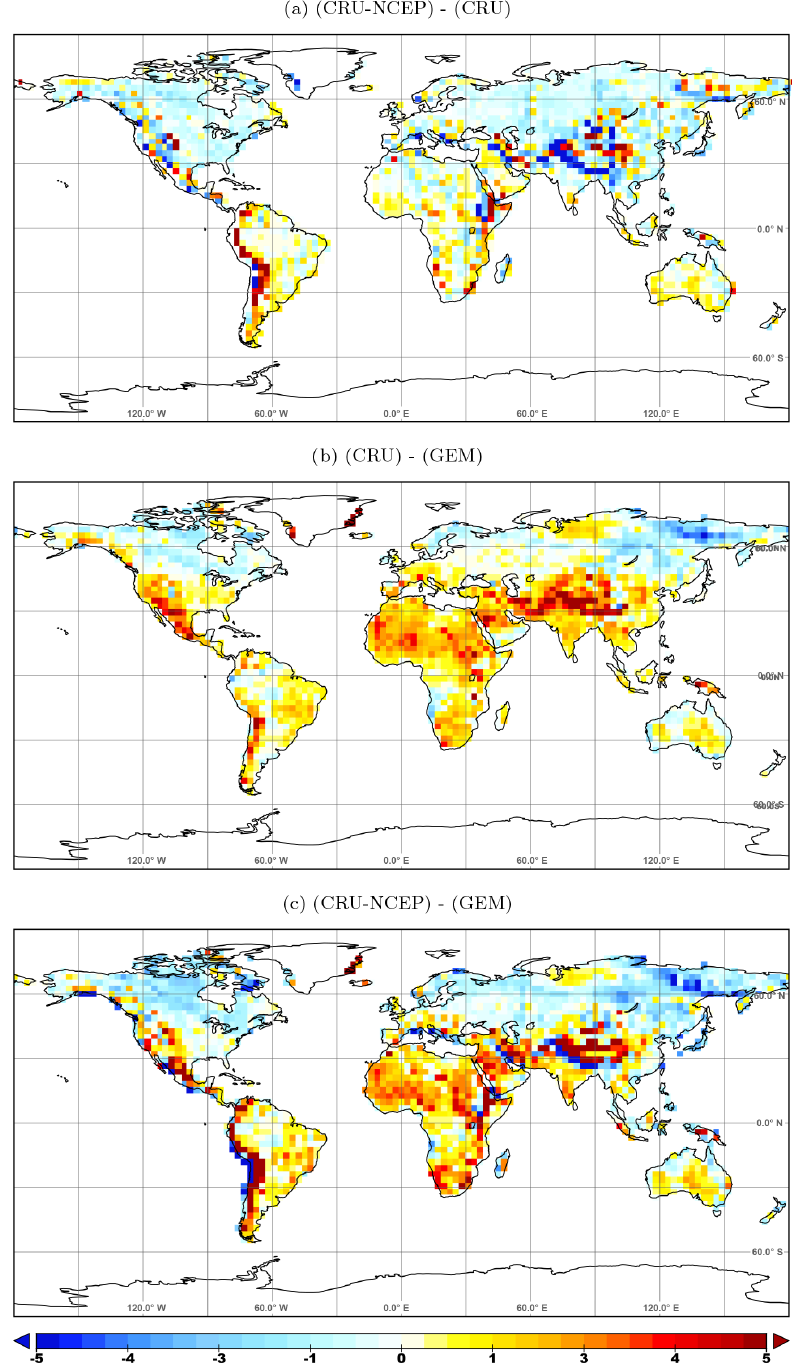
Figure 1. Comparison of spatial distribution patterns of annual mean temperature ( ◦ C) (averaged over the period 2009–2010): (a) CRU- NCEP minus CRU, (b) CRU minus GEM, and (c) CRU-NCEP minus